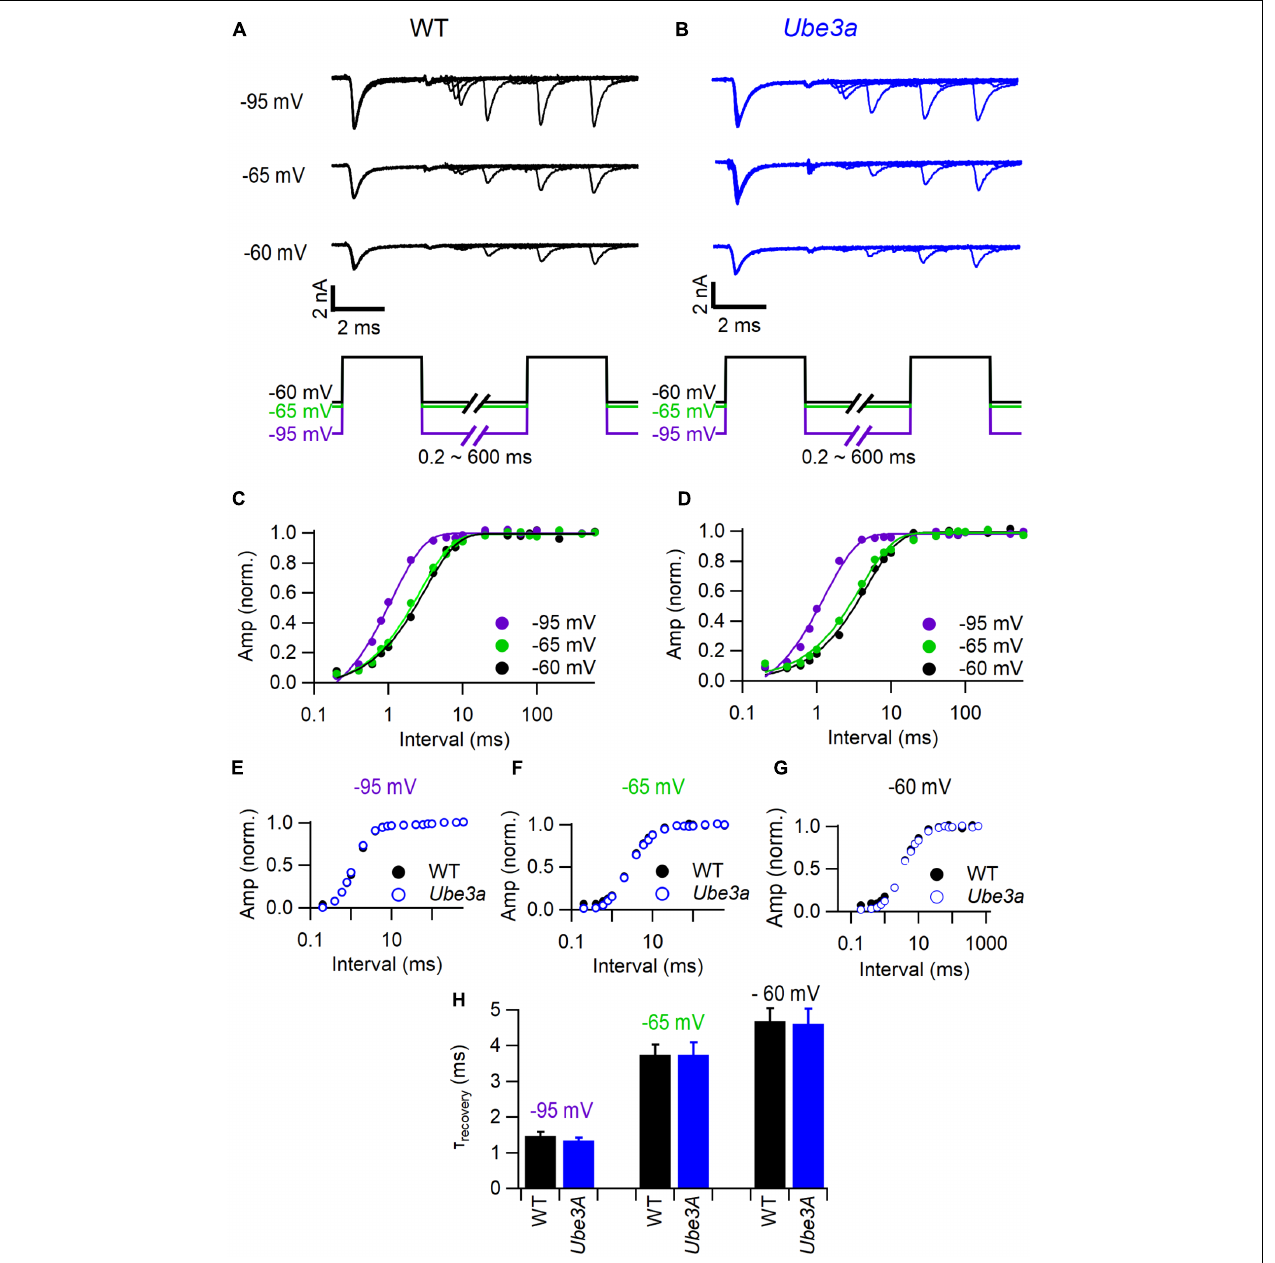
FIGURE 9 | Characterization of Na + current recovery. (A) Top panel shows superimposed sodium current recordings from a WT C57BL/6J mouse during two 3 ms depolarizations to − 10 mV at time intervals ranging from 0.2 to 600 ms from a holding potential of − 95, − 65, or − 60 mV, respectively; bottom panel shows the stimulation protocol. (B) As A , but from a Ube3a E113X mouse. (C) Dependence of the relative sodium current amplitude on the recovery time interval at a holding potential of − 95 mV (purple), − 65 mV (green), and − 60 mV (black); same cell as A ; lines indicate mono-exponential fit. (D) As C , but from the same cell as B . (E) Average recovery of sodium current at a holding potential of − 95 mV (purple) in wild type (filled circles) and Ube3a mutant mice (open circles). (F) As E , except holding potential − 65 mV (green). (G) As E , except holding potential − 60 mV (black). (H) Comparison of average recovery time constant in different holding potentials between wild type (black) and Ube3a E113X (blue)